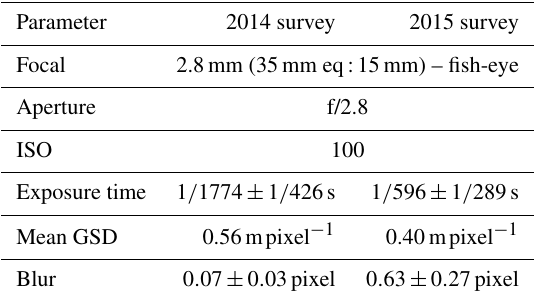
Table 1. Statistic summary of the image